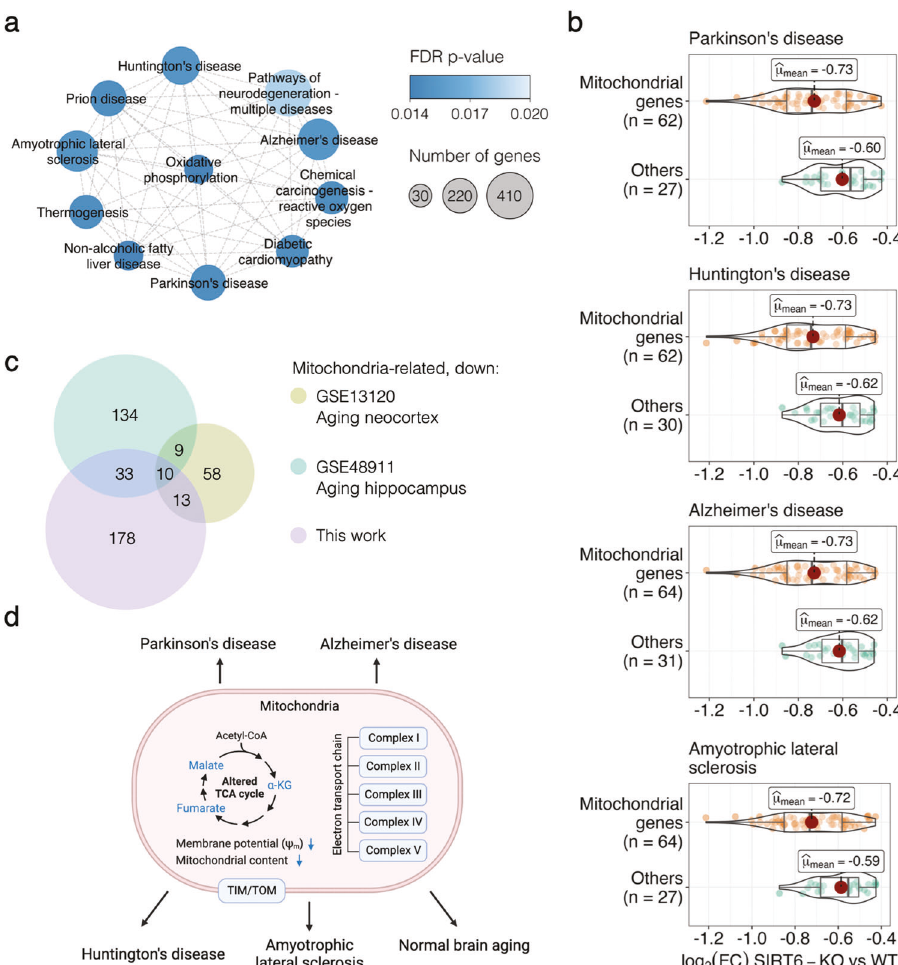
Fig. 5 SIRT6 silencing triggers neurodegenerative disease pathways and normal brain aging. a Cluster of enriched KEGG pathways obtained using GSEA. Each circle represents an enriched pathway and is colored according to the FDR p value. b Violin plots representing the log 2 (Fold Change) expression for genes with the largest contribution to the GSEA enrichment result per neurodegenerative pathway. c Euler diagram showing ten common downregulated genes between publicly available aging brain gene expression datasets (GSE13120 and GSE48911 accessions in the GEO database) and signi fi cantly downregulated mitochondrial genes from this study. d Proposed model of the mitochondrial dysfunction caused by SIRT6 silencing and its involvement in neurodegenerative diseases and normal aging. The fi gure was generated using the BioRender